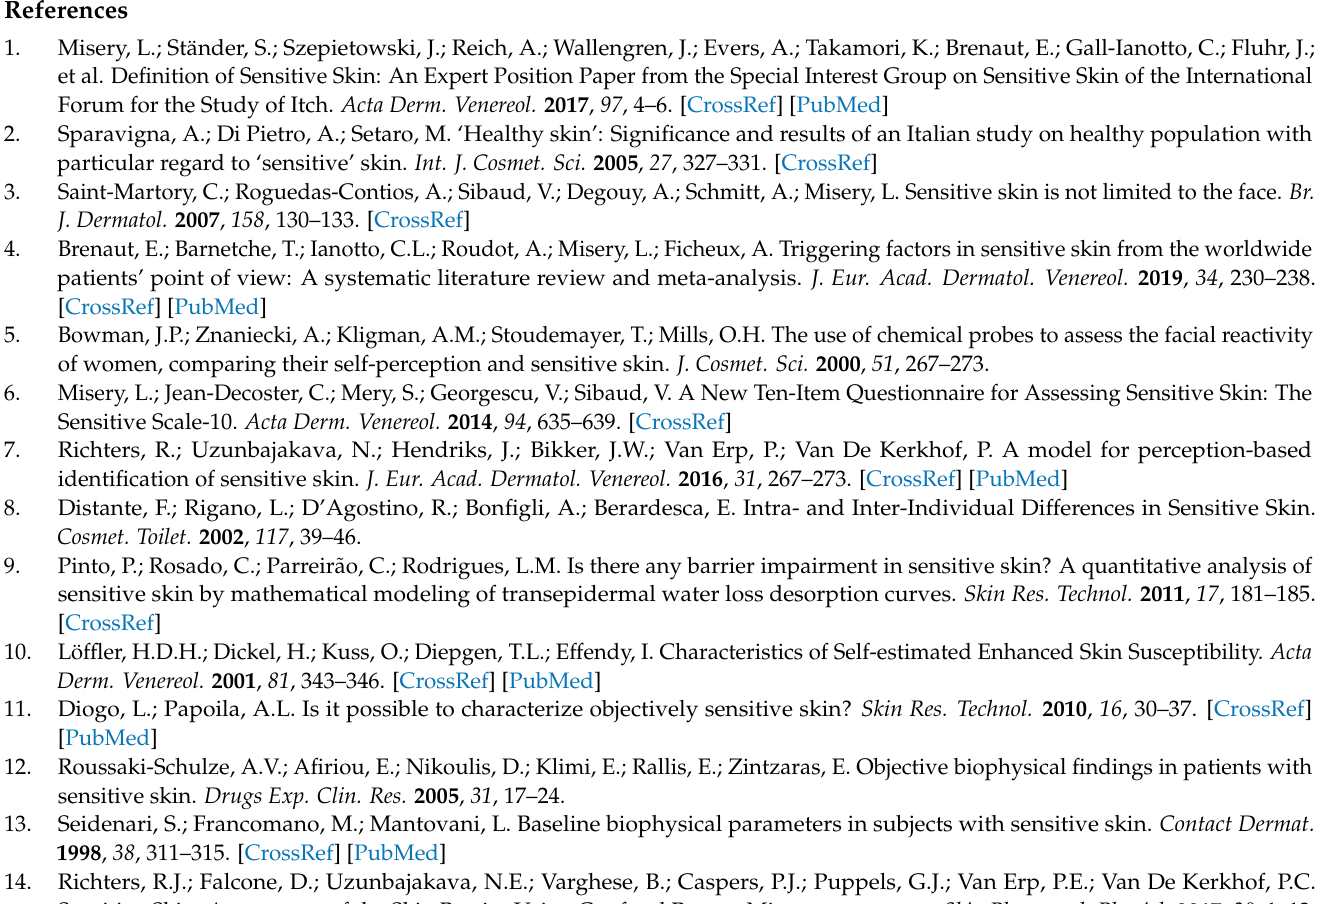
Figure A1. Percentage of objective and subjective reactions to each trigger for child and adult